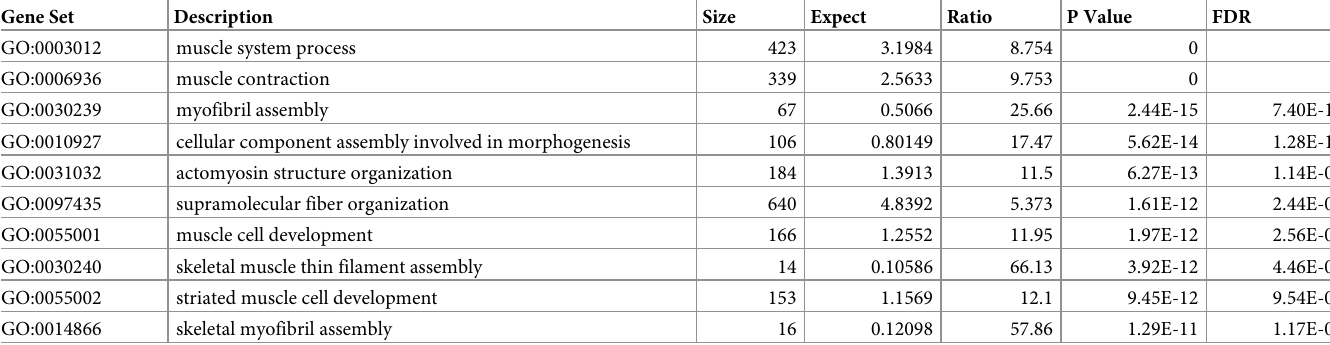
Table 2. GO terms enrichment of genes over-expressed at 32˚C. Gene